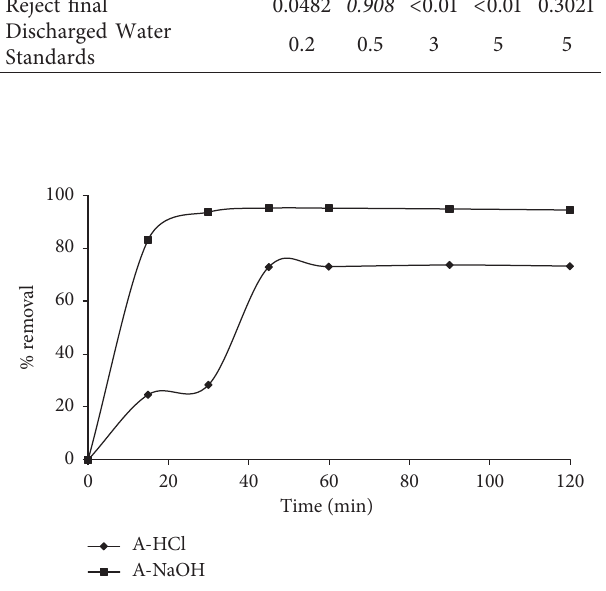
Figure 8: Adsorption kinetics of the industrial effluent on A-